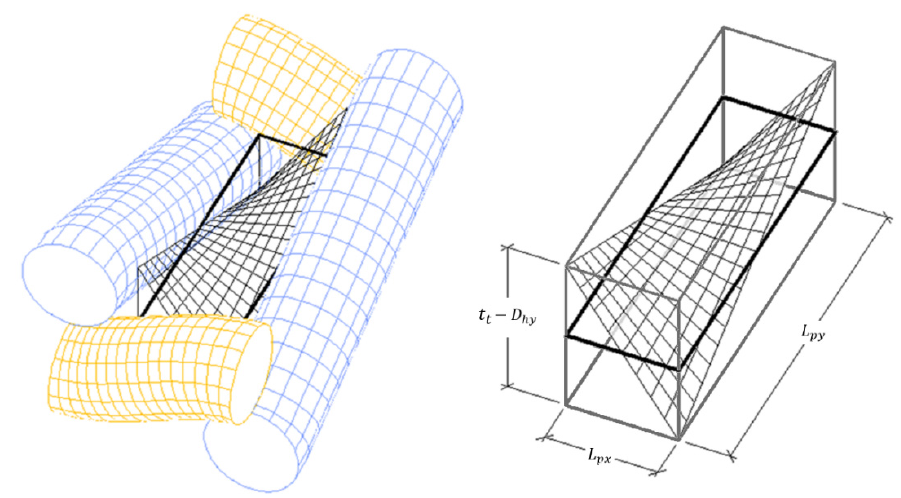
5 of 14 Figure 3. Microscopic image ( left ); same image analyzed by Euclides v.1.4 ( right ). However, all the above-mentioned parameters describe the screen from the point of view of its orthogonal projection. However, from a microscopic point of view, the spatial arrangement of the threads that make up the textile suggests that this 2D approach is not sufficient to explain the relationship between the screen and the insect. The real surface area that defines the three-dimensional space between the threads is a region of the hy- perbolic paraboloid [35], as can be seen in Figure 4. Using the variables that describe the protection screen from the 2D perspective (length L py and width L px of the hole and thick- ness of the warp thread D hy ), and considering the thickness of the textile t t measured using a micrometer (model 3050T, Baxlo) according to the standard ISO 5084: 1996 [36], the sur- face area of the screen measured in 3D can be calculated using the method proposed by